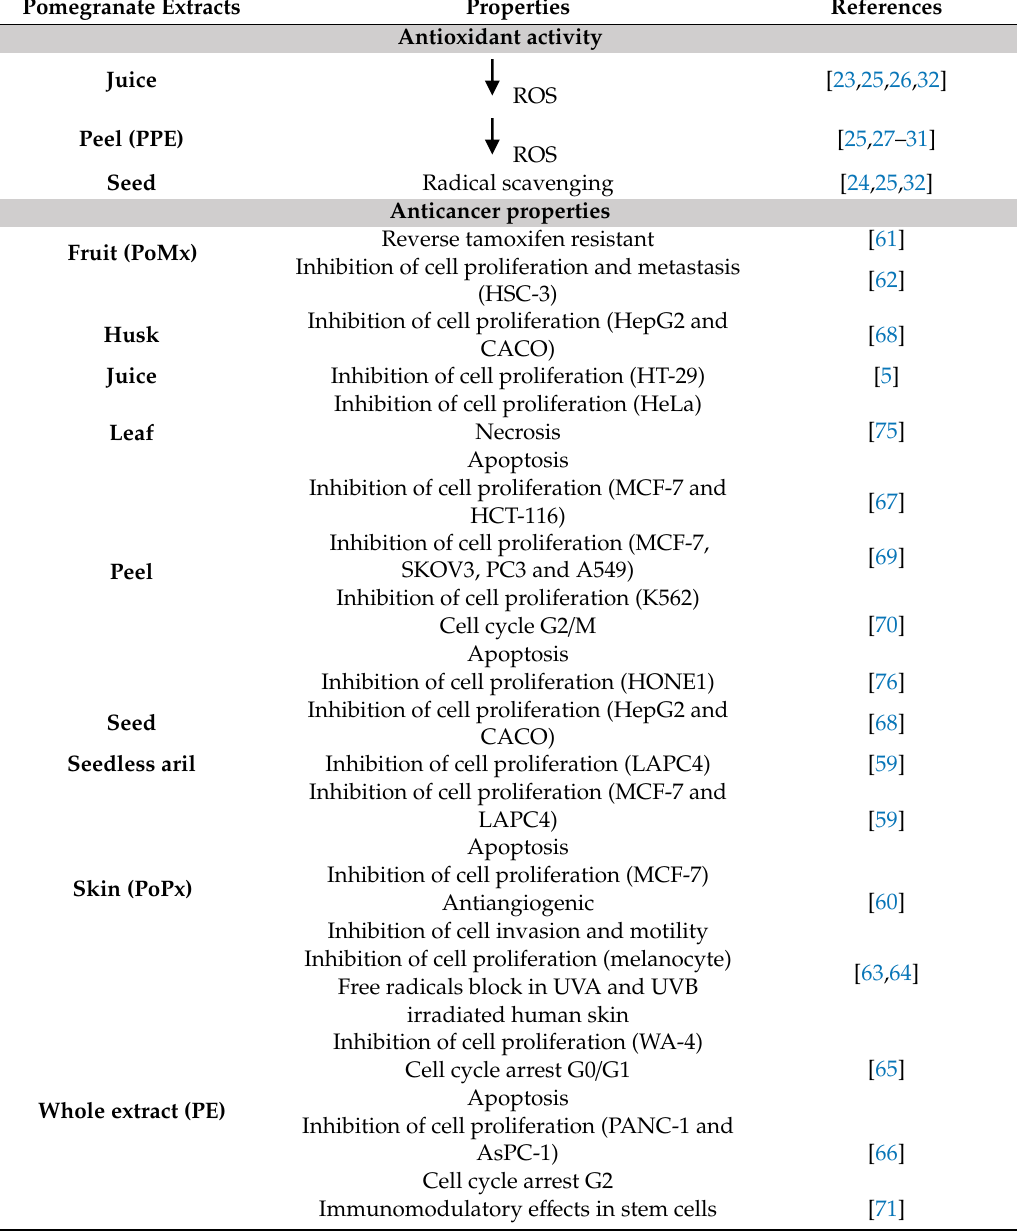
Table 2. Biological properties of different pomegranate extracts.